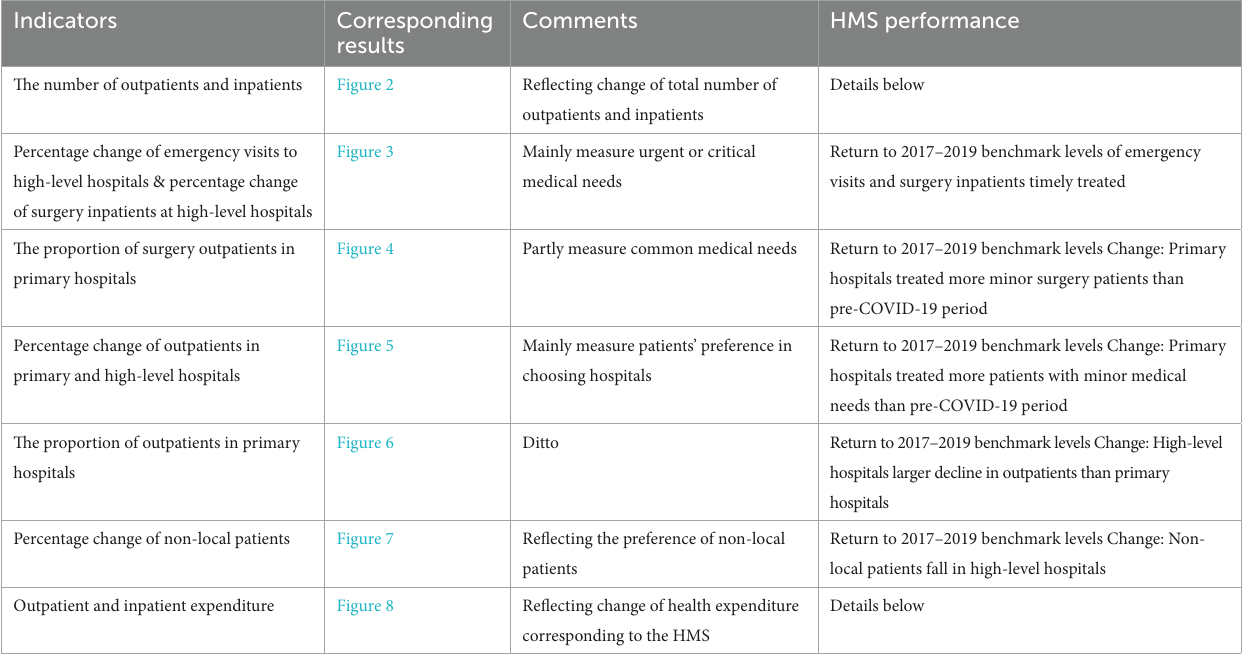
TABLE 1 Interpretation of the main performance